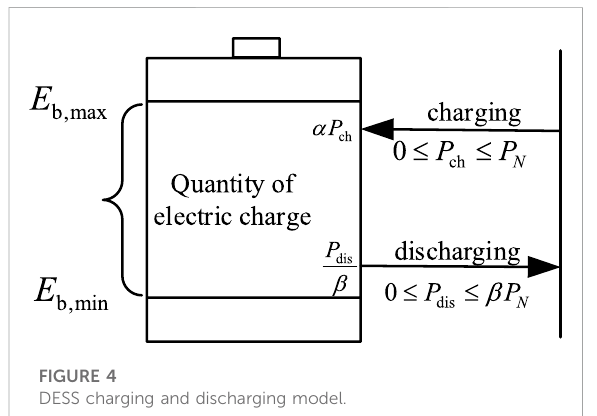
FIGURE 4 DESS charging and discharging model.